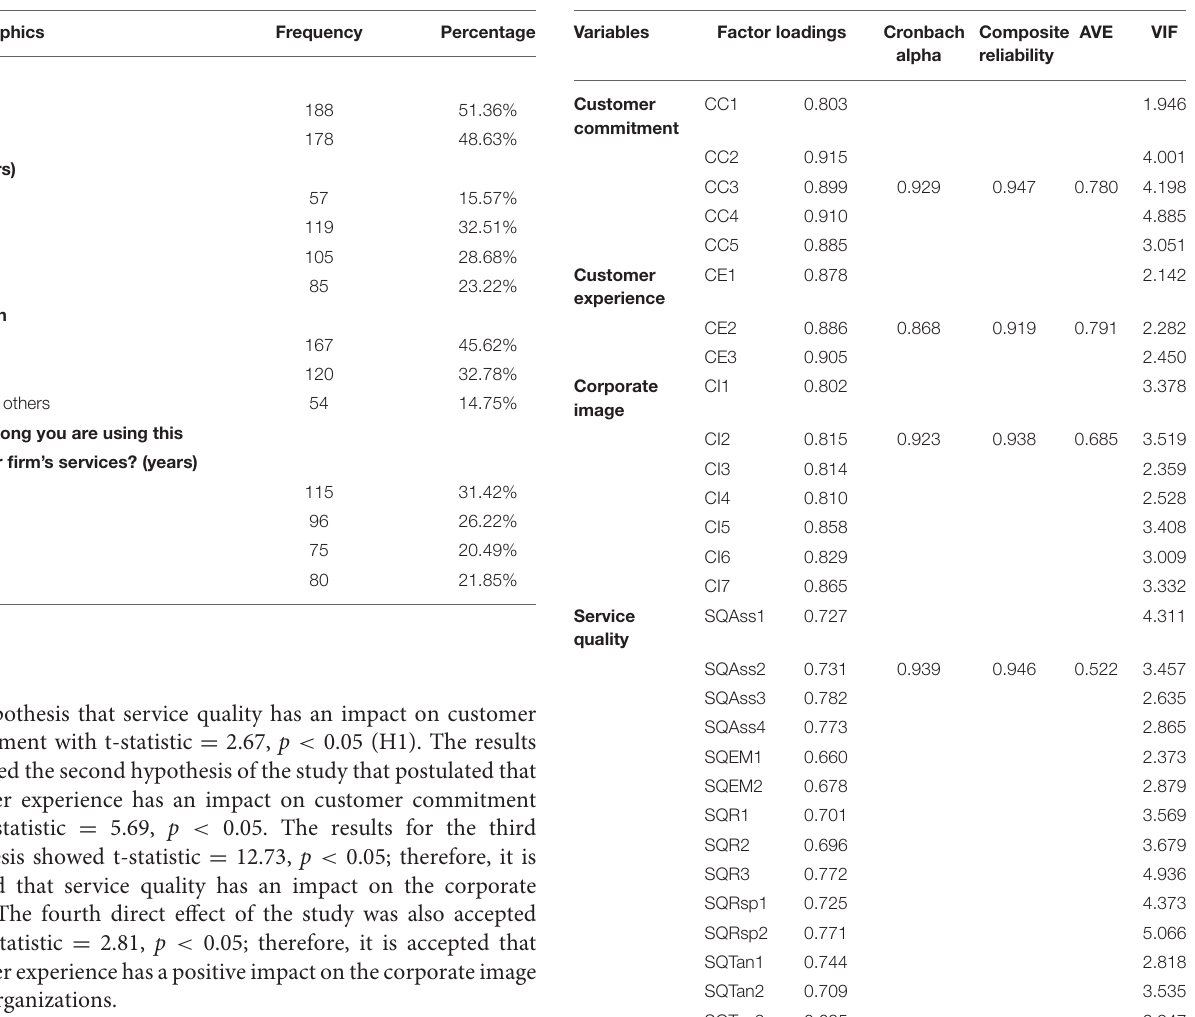
TABLE 1 | Demographics analysis. TABLE 2 | Outer model (measurement